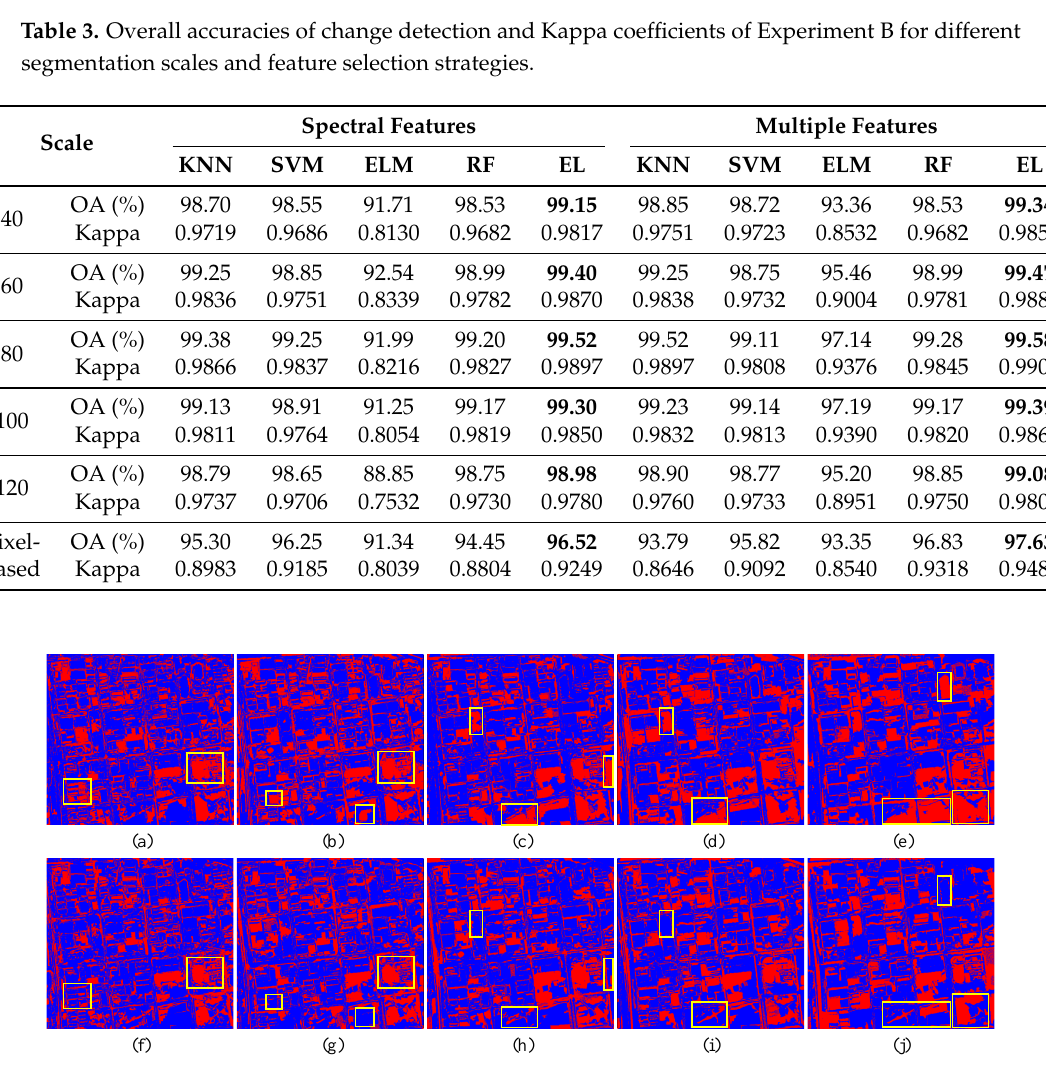
Figure 8. Change detection results of the EL method with one Monte Carlo run, where red denotes change and blue denotes non-change. ( a – e ) are the results with spectral features with the scale from 40–120 in steps of 20; ( f – j ) are the results with multiple features with the scale from 40–120 in steps of